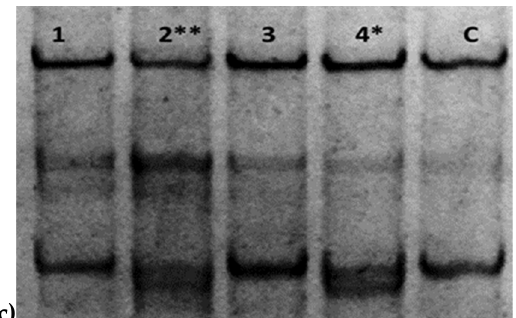
Figure 1. ( a ) Sequencing data of proband patient from Family 1 with PSEN1 T116I; ( b ) sequencing data of proband patient from Family 1 with PSEN1 T116I; and ( c ) SSCP data on PSEN1 T116I in Family 1. Number 2** is the proband patient and Number 4* is her affected sister. Numbers 1 and 3 are the asymptomatic and unaffected sisters. The ”C” means the control band, a PCR product of an individual, who was verified as wild type for PSEN1 exon 5. Star means that these individuals are affected with mutation.